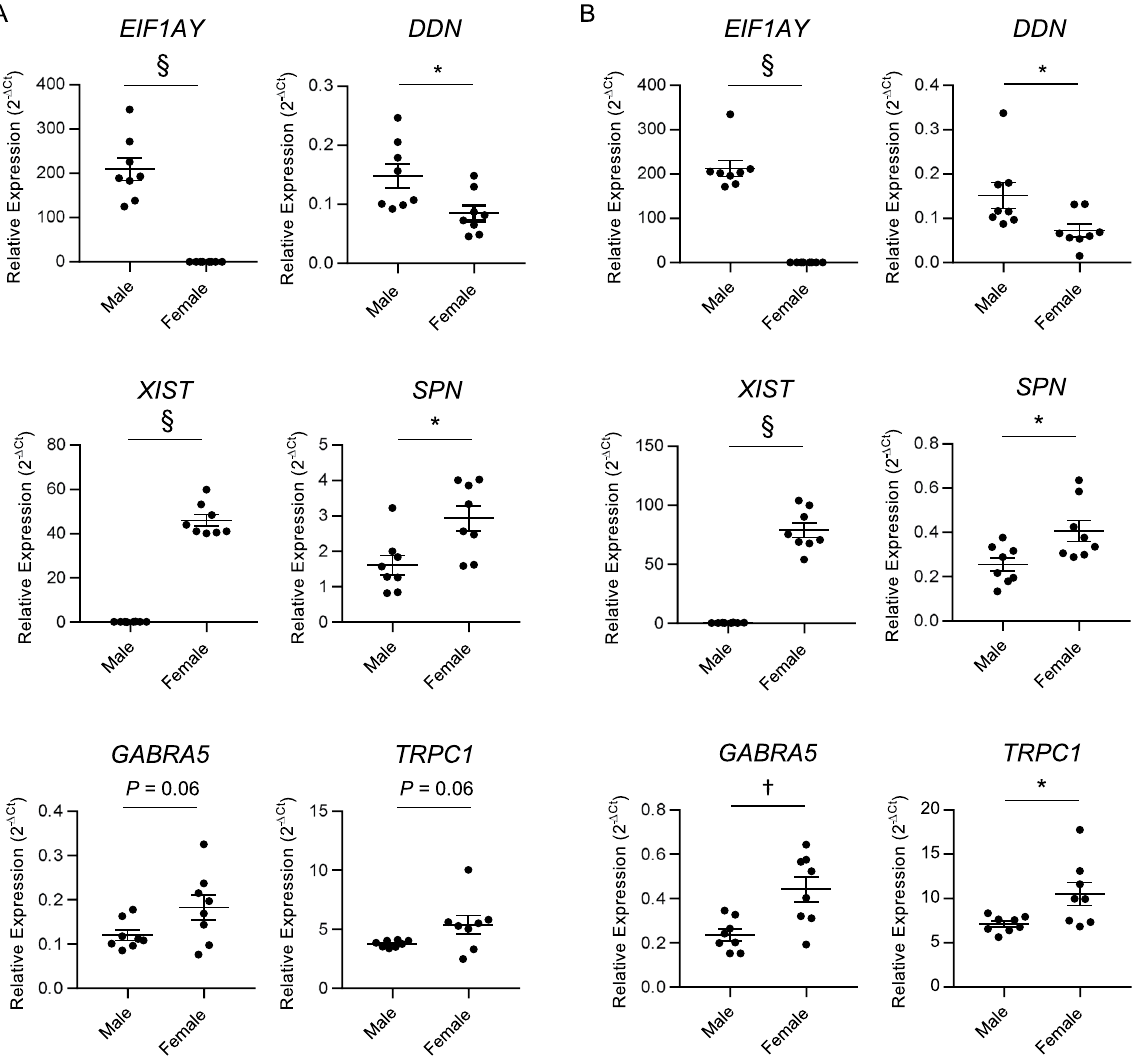
Figure 6. Sex differences in non-failing human heart expression profiles. Comparisons of transcripts encoding genes expressed at higher levels in male ( EIF1AY and DDN) or female ( XIST, SPN, GABRA5 and TRPC1) ( A ) LA and ( B ) RA were determined using quantitative RT-PCR (see Methods and Materials). Mean ± SEM (N = 8) values are indicated and the individual normalized expression values are plotted. * ,†,§ Values indicated are significantly different at the * P < 0.05, † P < 0.01 and § P < 0.0001